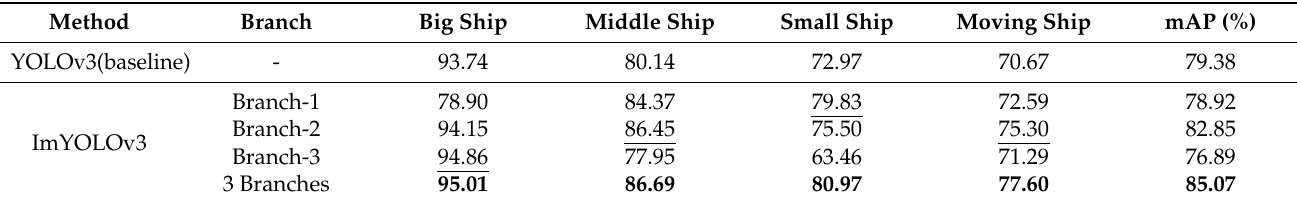
Figure 6. Ship detection results on the MSD dataset using different number of dilated blocks in DAM. Table 2. Ship detection results of each branch in ImYOLOv3 evaluated on the MSD dataset. The dilation rates of three branches in ImYOLOv3 are set as 1, 2, and 3. The entries with the best APs for each object category are boldfaced and the suboptimal entries are